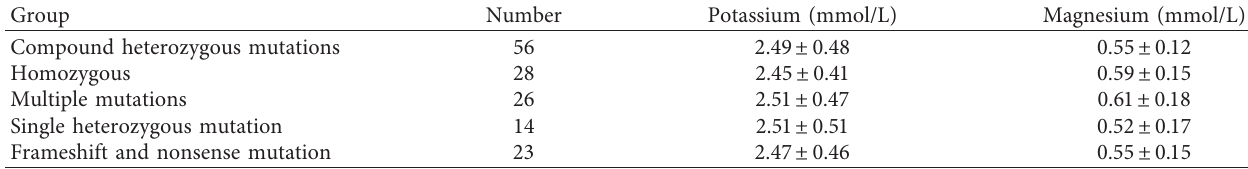
Table 3: Comparison of blood potassium and blood magnesium levels across the different mutation types ( x ± s ).